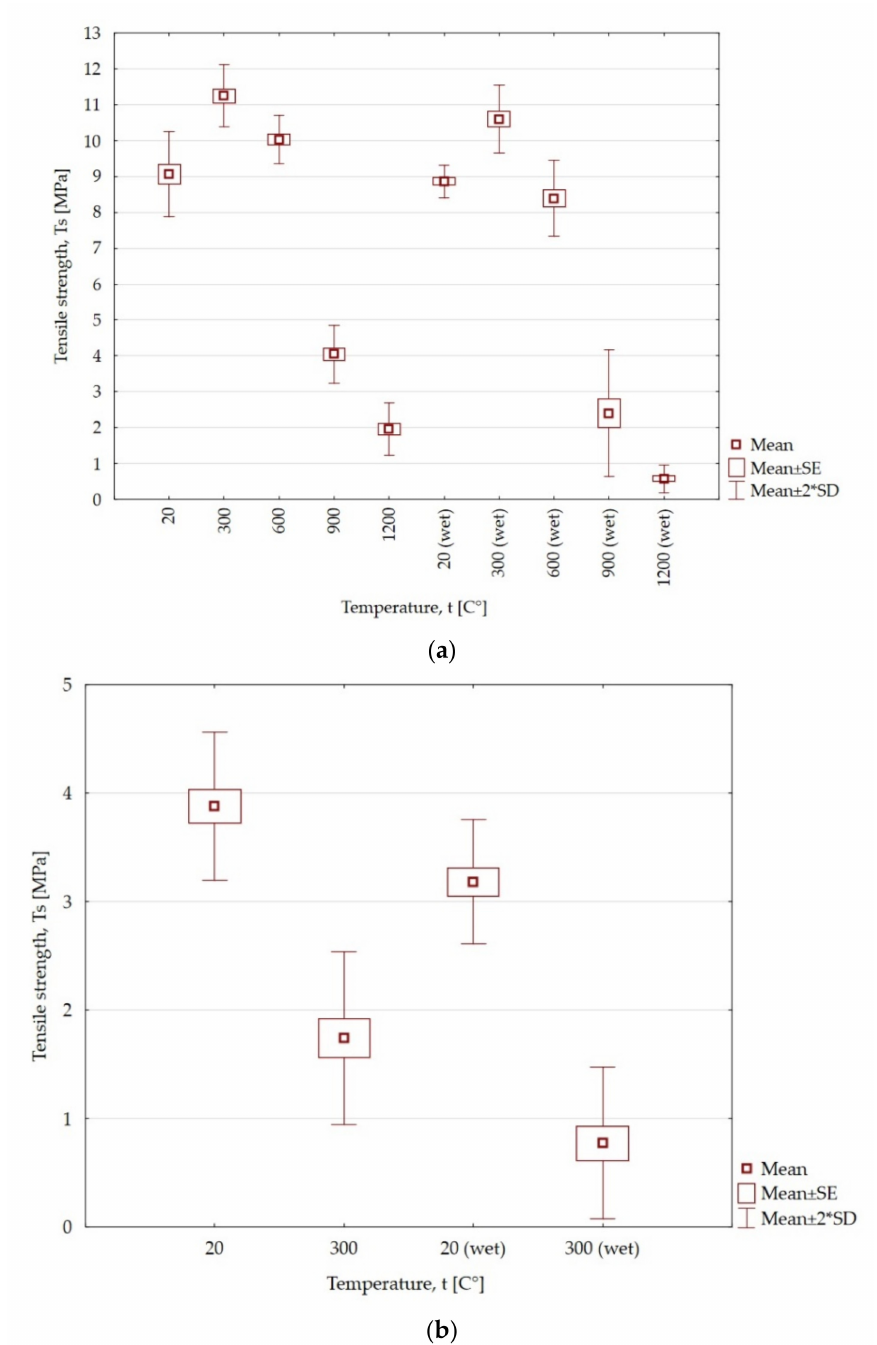
Figure 6. The influence of high temperatures on changes in tensile strength of dry and wet samples: ( a ) sandstone; ( b ) claystone; SE—standard error; SD—standard